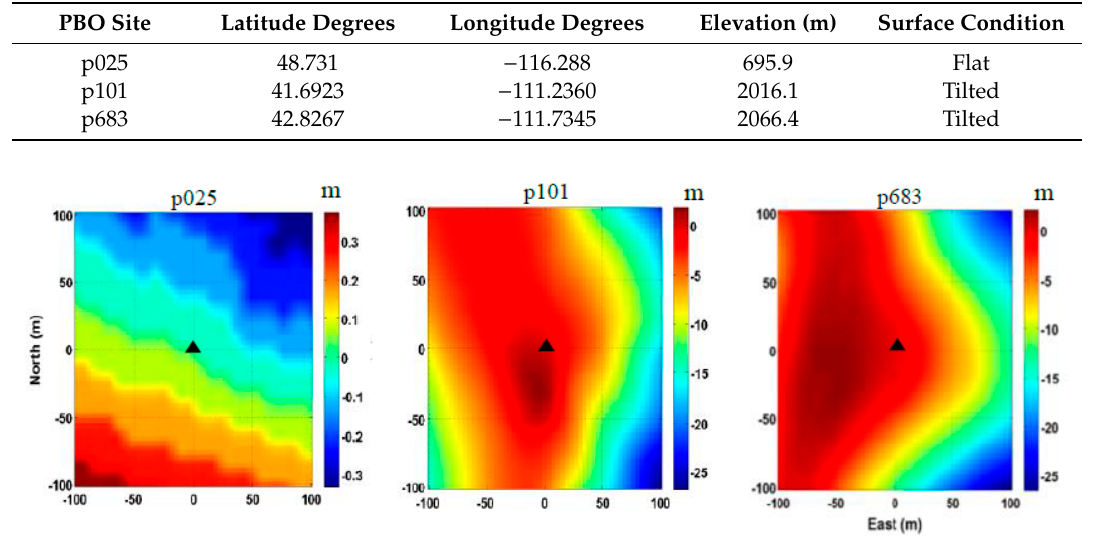
Figure 1. Three selected Global Positioning System (GPS) sites of the Plate Boundary Observatory (PBO) network in the western United States. Table 1. Locations of the selected GPS sites.